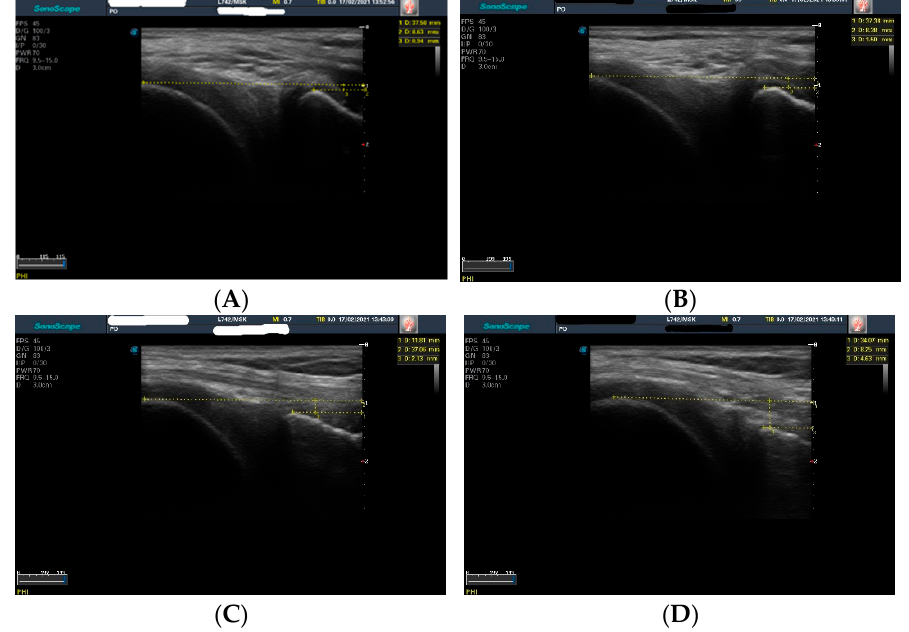
Figure 2. Anterior tibial translation measurements in uninjured and injured knee. ( A ). Static anterior tibial translation in uninjured knee (D1uninjured = 0.94 mm); ( B ). Dynamic anterior tibial translation (manual pressure was applied in the proximal posterior aspect of the calf) in uninjured knee (D2un- injured = 1.5 mm); ( C ). Static anterior tibial translation in injured knee (D1injured = 2.13 mm); ( D ). Dynamic anterior tibial translation (manual pressure was applied in the proximal posterior aspect of the calf) in injured knee (D2injured = 4.63 mm).